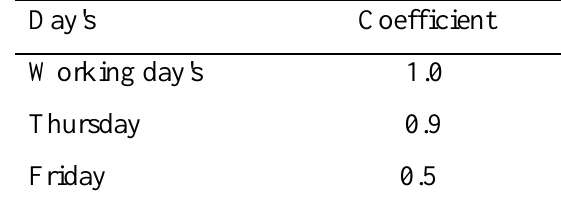
Table 2. Alternate factor all the day's in a week for the